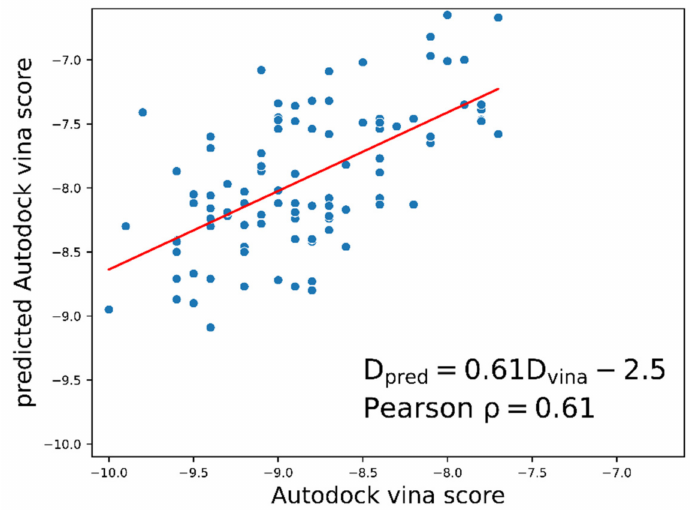
Figure 6. The correlation coefficient between the calculated docking energy and the predicted docking energy. The correlation coefficient between the calculated docking energy and the predicted docking energy is 0.61, using 100 molecules with the lowest objective function value among the generated molecules. This implies that the trained prediction model predicts the dataset and the docking energy of the newly generated molecules